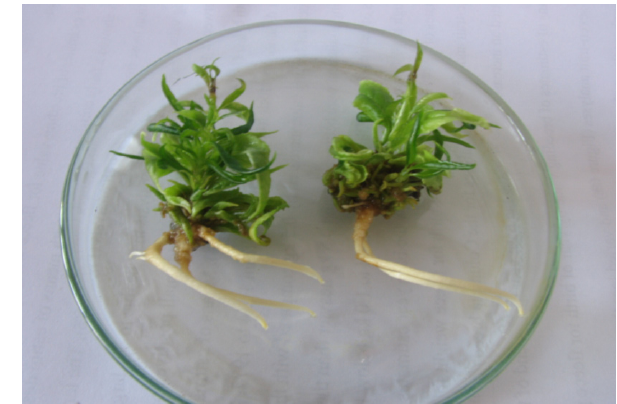
Fig. 1. Multiple shoot proliferation on a MS medium with IAA (0.5 mgL -1 ) and BA (1 mgL -1 )